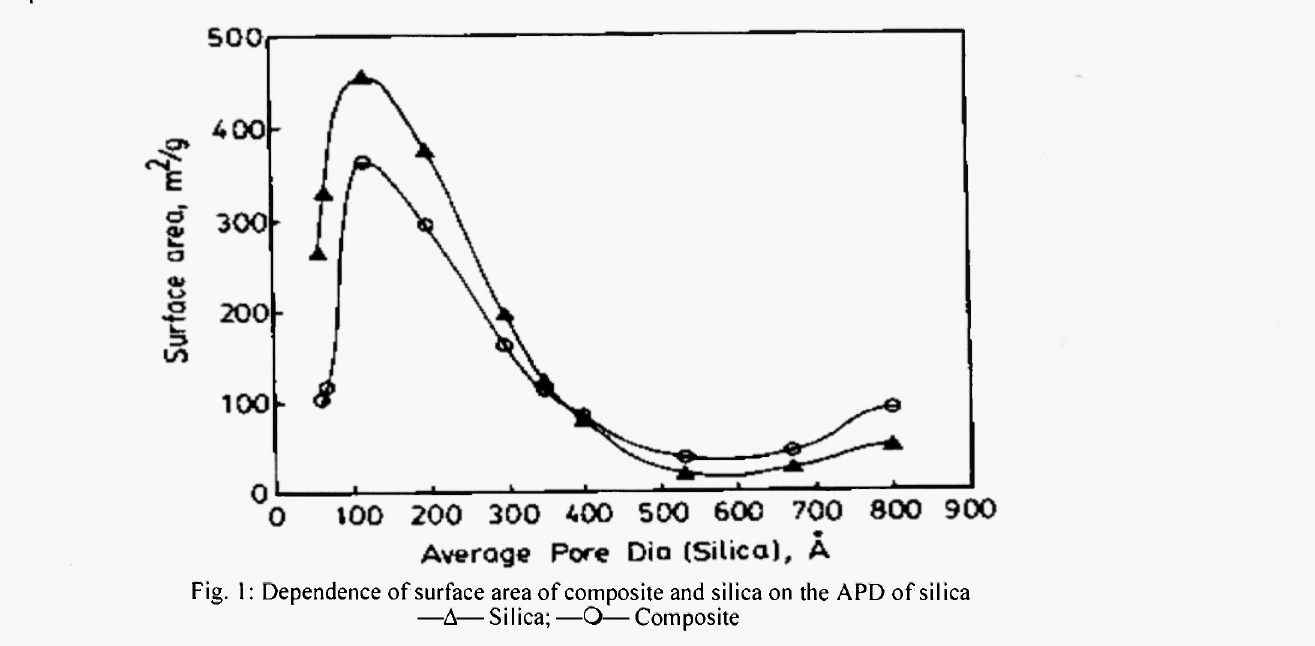
Fig. 1: Dependence of surface area of composite and silica on the APD of silica — Δ— Silica;